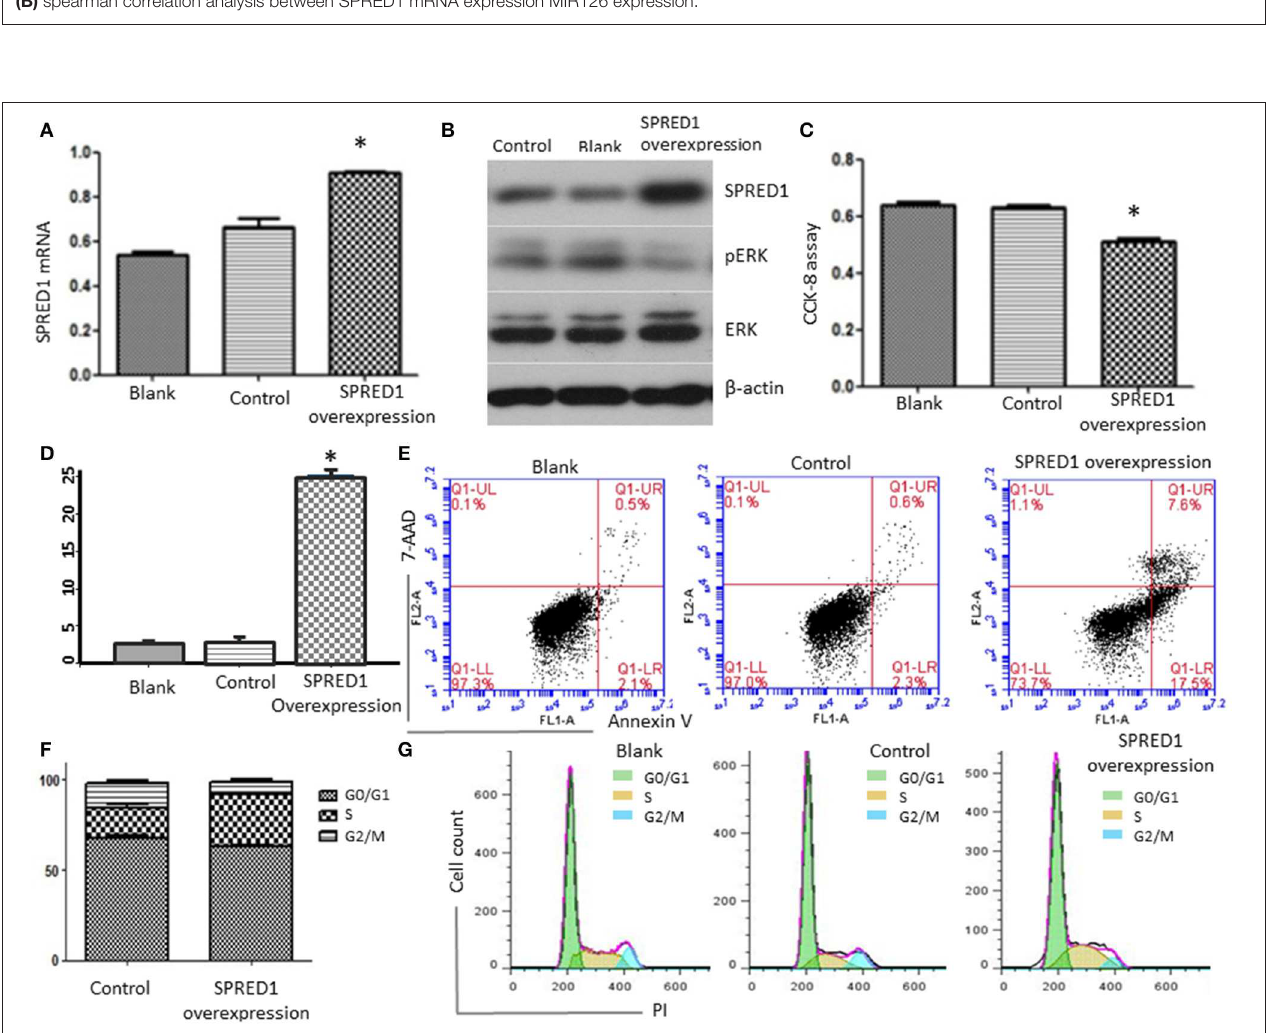
FIGURE 7 | THP-1 cells were transfected with SPRED1 plasmid for 48h. (A) SPRED1 mRNA was determined by RT-PCR in the blank; (B) SPRED1, pERK, ERK, and β -actin) were assessed by immunoblotting; (C) cell proliferation was determined by CCK-8 assay; (D,E) cell apoptosis was assessed by using annexin V–PE/7-AAD staining and (F,G) cell cycle distribution was assayed by flow cytometry. * p < 0.05 vs. control (Student’s t -test).